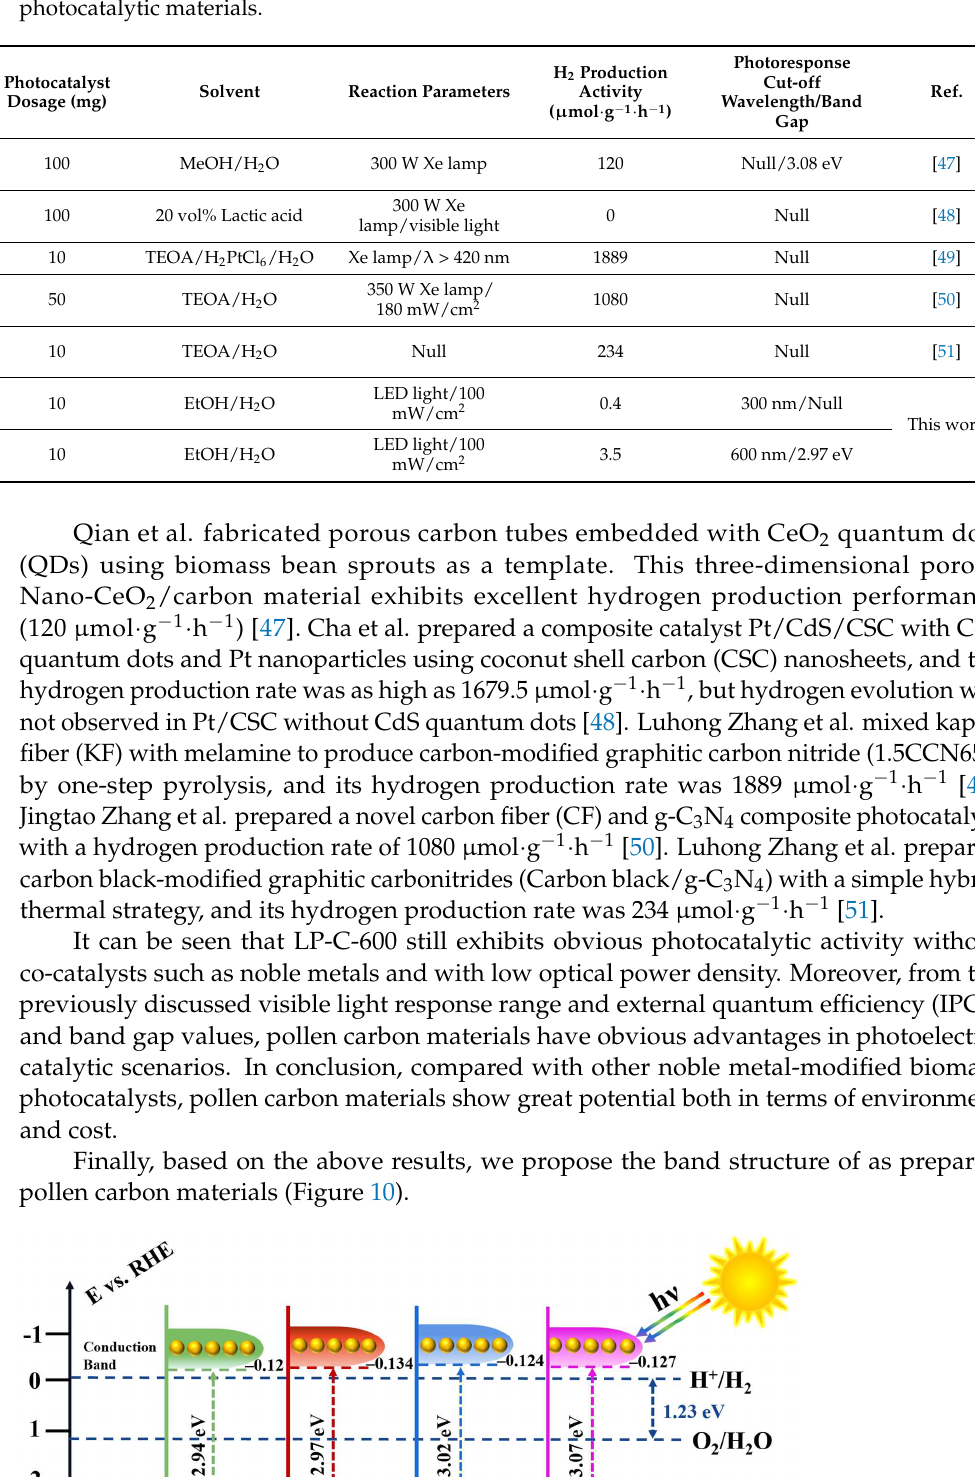
Table 2. Reported hydrogen evolution rates and specific test conditions for bio-templated photocatalytic materials.